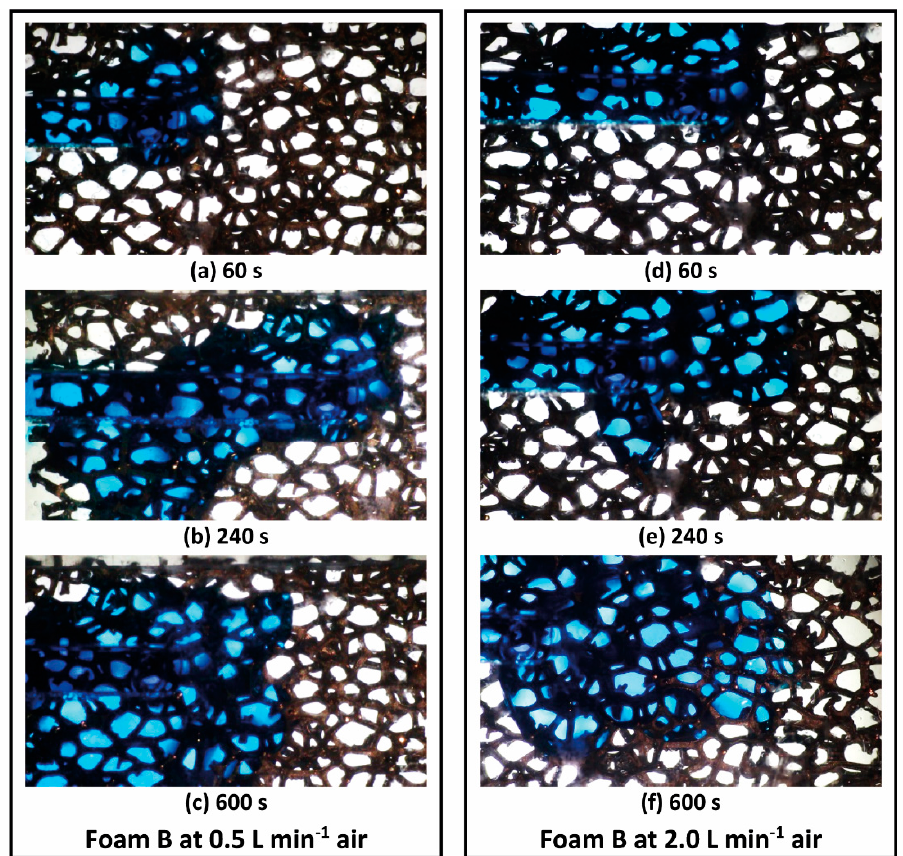
Figure 6. Propagation of liquid water in foam B (3.0 mm thick), air flow (left to left), 7.7 mm × 5.0 mm field of view. After ( a ) 60 s, ( b ) 240 s and ( c ) 600 s at 0.5 L min − 1 air flow and ( d ) 60 s, ( e ) 240 s and ( f Table 2. Time for liquid water to reach the end of the foam sample after initially entering at 3.0 gh − 1.